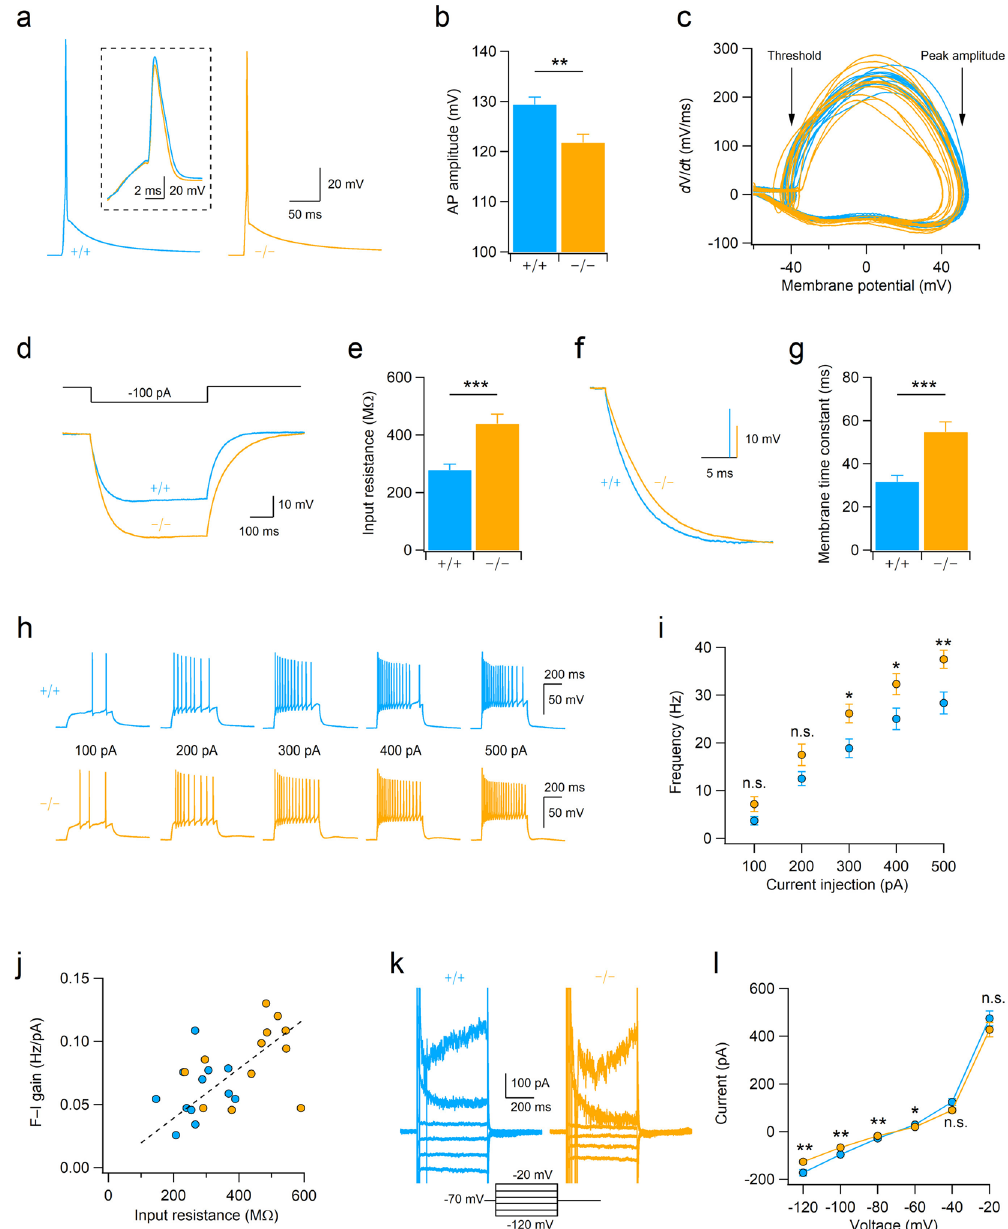
Figure 7. Hyperexcitability of CA3b pyramidal neurons in mice lacking aminopeptidase P1. ( a ) Mean traces of APs (n = 12 for each genotype) recorded in the CA3b pyramidal neurons. Inset, enlarged traces showing the peak amplitudes and time course of AP spikes. ( b ) Bar graphs represent the amplitude of APs in CA3b neurons. t (22) = 3.386, ** p = 0.003 by Student’s t -test. ( c ) First order derivatives (dV/dt) of the membrane potential during the action potential were calculated from WT (n = 12, blue traces) and Xpnpep1 −/− (n = 12; orange traces) CA3b neurons and plotted as a function of membrane voltage. ( d ) Sample traces of voltage response to hyperpolarizing current injection (500 ms) in CA3b pyramidal neurons. ( e ) Bar graphs represent the input resistance of CA3b pyramidal neurons measured by the hyperpolarizing step shown in ( d ). t (22) = − 4.15, *** p < 0.001 by Student’s t -test. ( f ) Voltage responses shown in ( d ) were normalized to their maximum amplitude, and the initial portion of the responses is shown with an expanded time scale. ( g ) Increased membrane time constant in Xpnpep1 −/− CA3b neurons. t (22) = − 4.10, *** p < 0.001 by Student’s t -test. ( h ) Sample traces of APs recorded in CA3 neurons in response to depolarizing current pulses (100–500 pA, 500 ms). ( i ) Averaged F–I curves in CA3 pyramidal neurons from WT (n = 12 from 3 animals) and Xpnpep1 −/− (n = 12 from 3 animals) mice. n.s., not significant ( p > 0.05); * p < 0.05; ** p < 0.01 by Student’s t -test. ( j ) The slopes of the F–I relationship measured between 100 and 300 pA of input current were plotted against R in of each cell. The dashed line represents the best fit for the linear relation between the F–I gain and R in . ( k ) Sample traces of membrane currents measured from WT and Xpnpep1 −/− CA3b neurons. Inset, Voltage steps elicited from a holding potential of − 70 mV in 20 mV increments from − 120 to − 20 mV. ( l ) Current–voltage (I–V) relationship for net membrane current at the end of the voltage step recorded from Xpnpep1 +/+ (n = 13 cells from 3 animals) and Xpnpep1 −/− (n = 13 cells from 3 animals) CA3b neurons. n.s., not significant ( p > 0.05); * p < 0.05; ** p < 0.01 by Student’s t